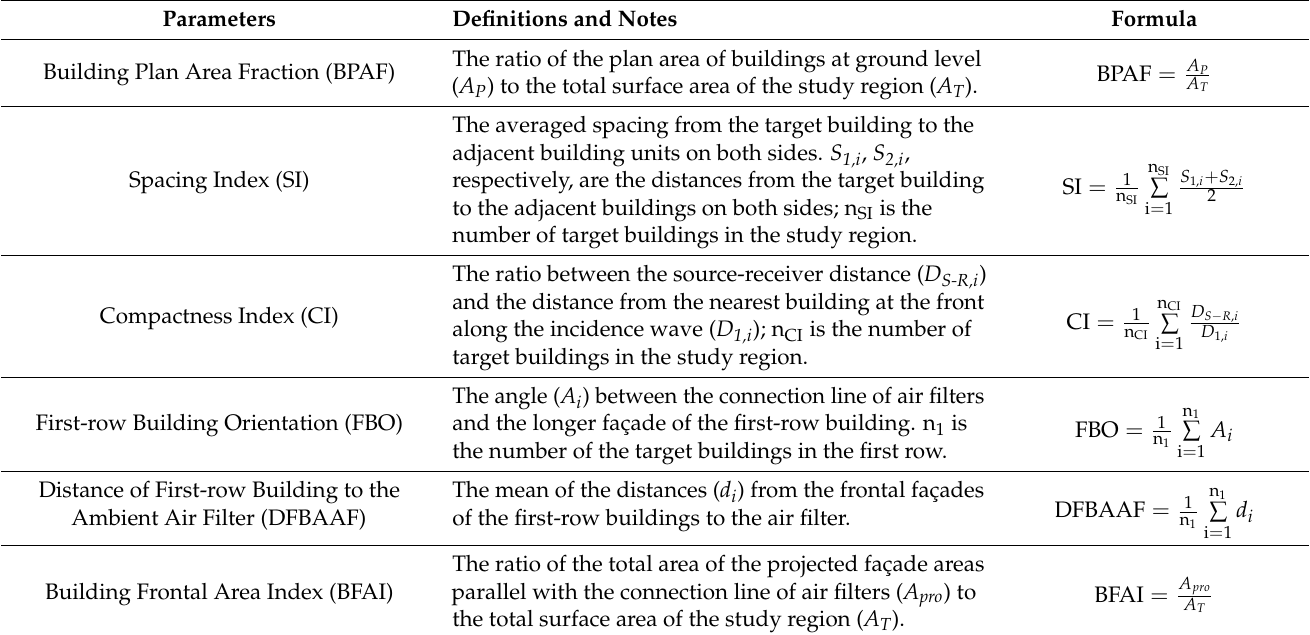
Table 3. Definitions and calculations of the six urban form indices used in this